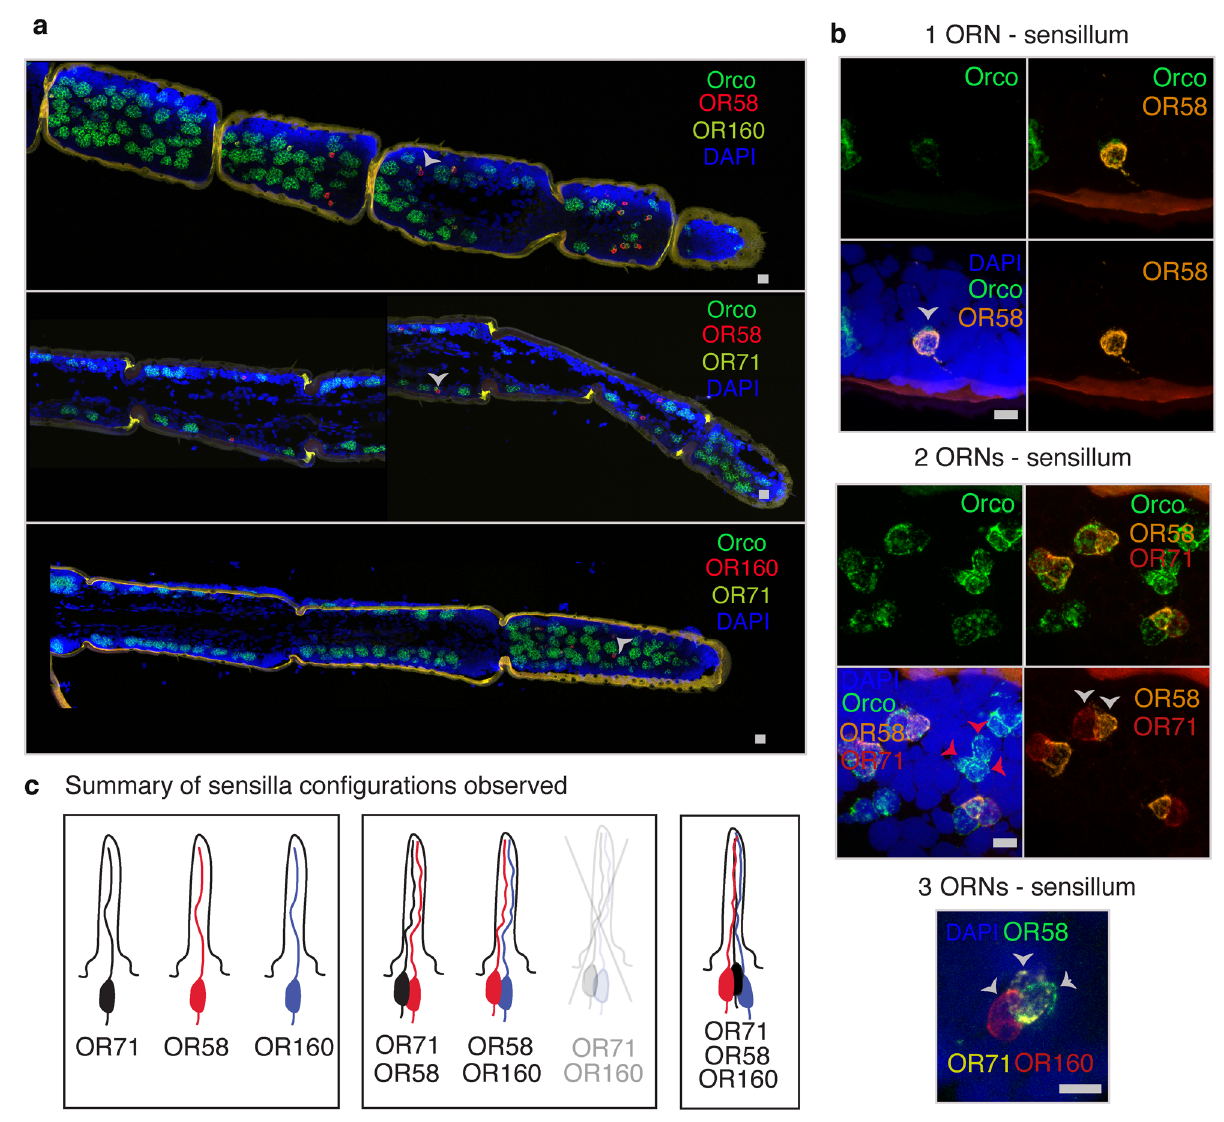
Figure 4. Characterization of SameOR71, SameOR58, and SameOR160 expression in trichoid sensilla. RNAscope in situ hybridization was used to determine the spatial distribution of these putative ORs. ( a ) Examples of antenna sections showing different combinations of probes against SameOrco and SameOR58 + SameOR160 (top), SameOR58 + SameOR71 (middle), and SameOR160 + SameOR71 (bottom), respectively. ( b ) Examples of individual trichoid sensilla containing one, two, or three ORNs and different combinations of the SameORs tested and indicated by gray arrows. Note that the images showing one and two ORNs are the same as in Fig. 3b but with additional color channels. Middle panel: red arrows: a cluster of three Orco + cells that do not express either of the two tested putative SameORs. ( c ) Summary of the configurations observed in trichoid sensilla. Scale bars: 20 and 10 μm in panel a and b,